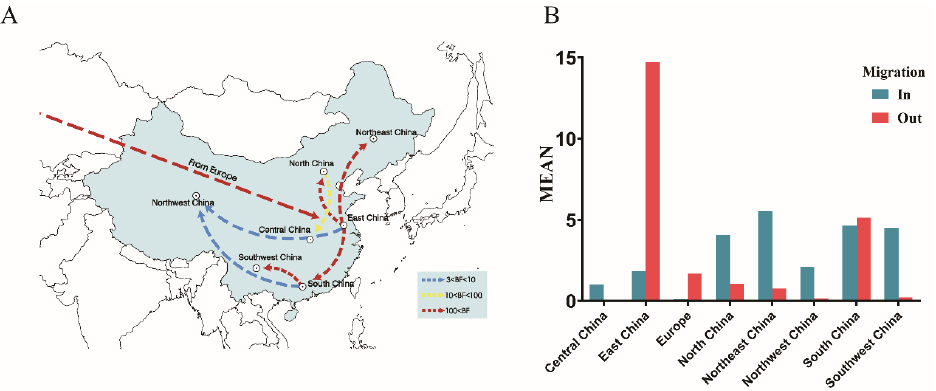
Figure 5. Spatial diffusion of VI.2.1.1.2.2 viruses. ( A ) Spatial diffusion pathways. ( B ) Histogram of the total number of state transitions.